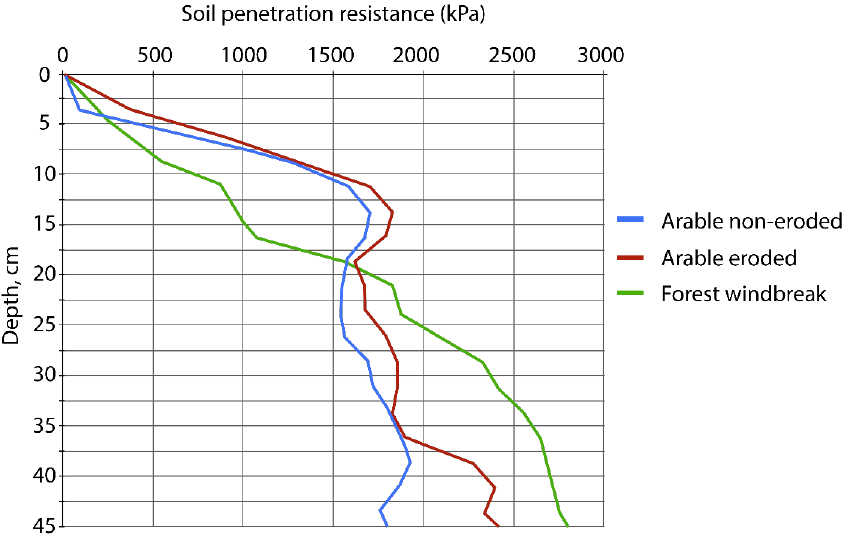
Figure 2. Vertical distribution penetration resistance of soils under arable and forest plots (mean values for 10 replicates for each soil type).